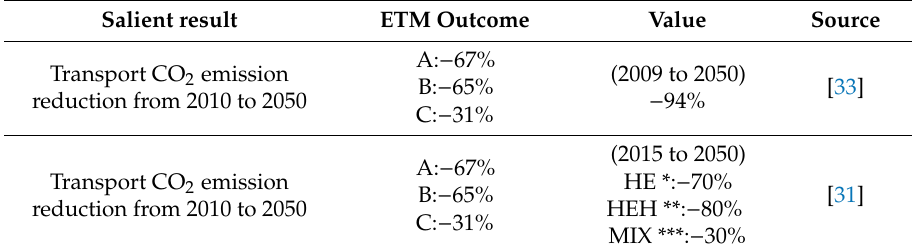
Table 14. CO 2 emissions from the transport sector: ETM vs. other model